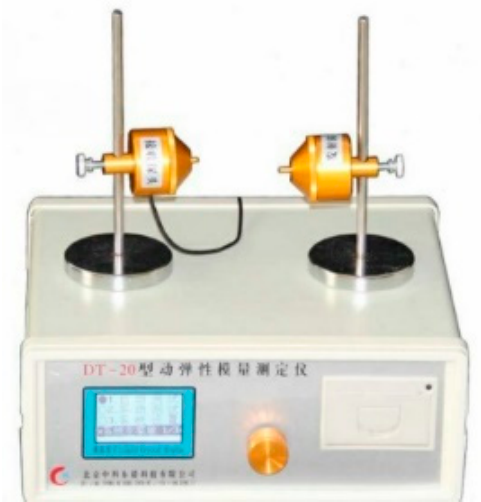
Figure 3. DT-20 Dynamic Elastic Modulus Measurement instrument.